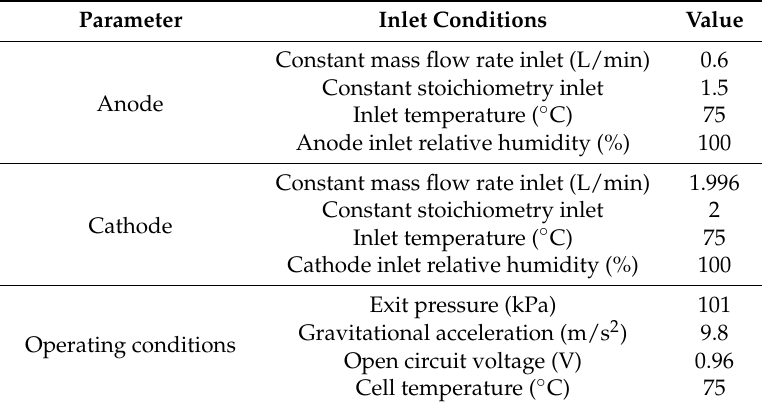
Table 4. Details of the operation conditions used in this research